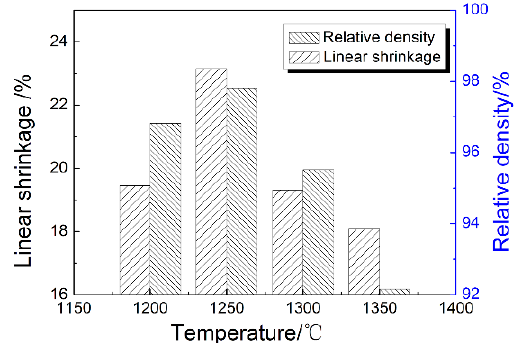
Figure 8. Linear shrinkage and density at different sintering temperatures of ZrO 2 ceramic nozzles with multi-micro-holes using 100 nm powder.